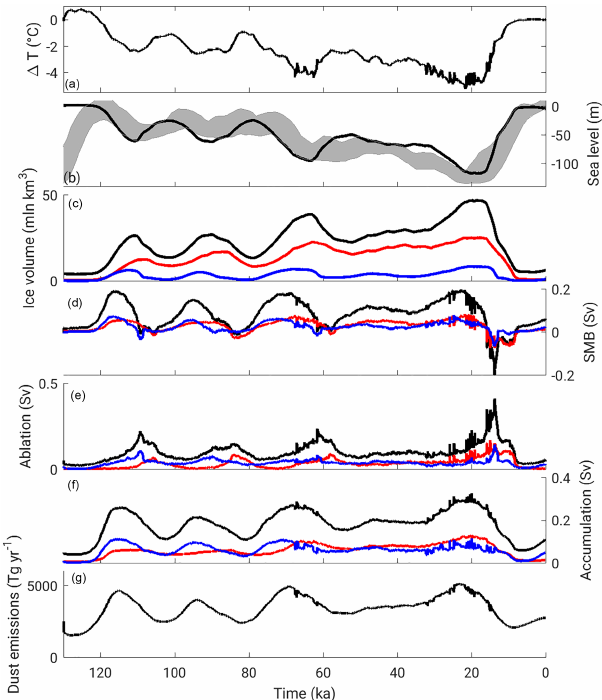
Figure 2. Simulated (a) global temperature anomaly, (b) sea level, (c) ice volume, (d) surface mass balance, (e) ablation, (f) accu- mulation and (g) global dust emissions for the reference experi- ment. The red and blue lines in (c) – (f) represent the Laurentide and Fennoscandian ice sheet, respectively. The shading in (b) is the sea level range from Spratt and Lisiecki